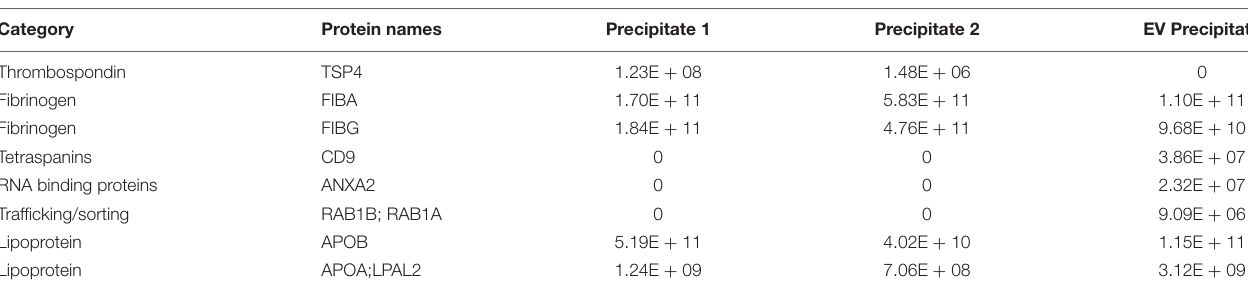
FIGURE 1 | Separation process of plasma samples. Four fractions were obtained after sequential physical and chemical precipitation: (1) platelets and cell debris, named precipitate 1; (2) fibrins, named precipitate 2; (3) extracellular vesicles, named EV precipitate; (4) supernatant, named leftover fraction. Except for supernatant, each fraction was suspended by 100 µ l of PBS Buffer before RNA extraction. TABLE 2 | Characterization of plasma fractions by